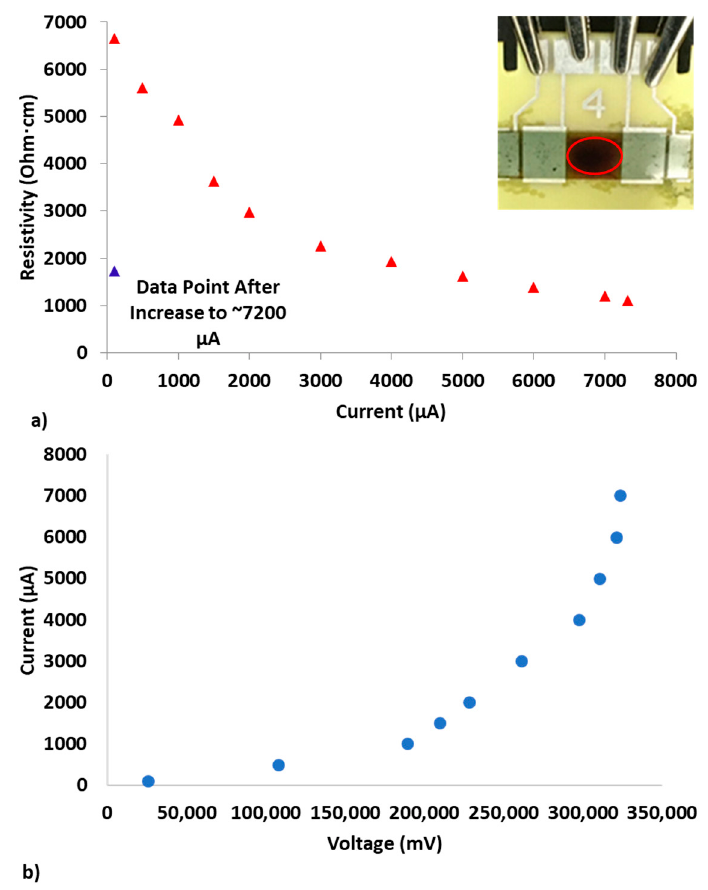
Figure 6. Current increase to above 7000 µ A for 0.014 wt% sample; ( a ) resistivity vs. current; ( b ) current vs. voltage .